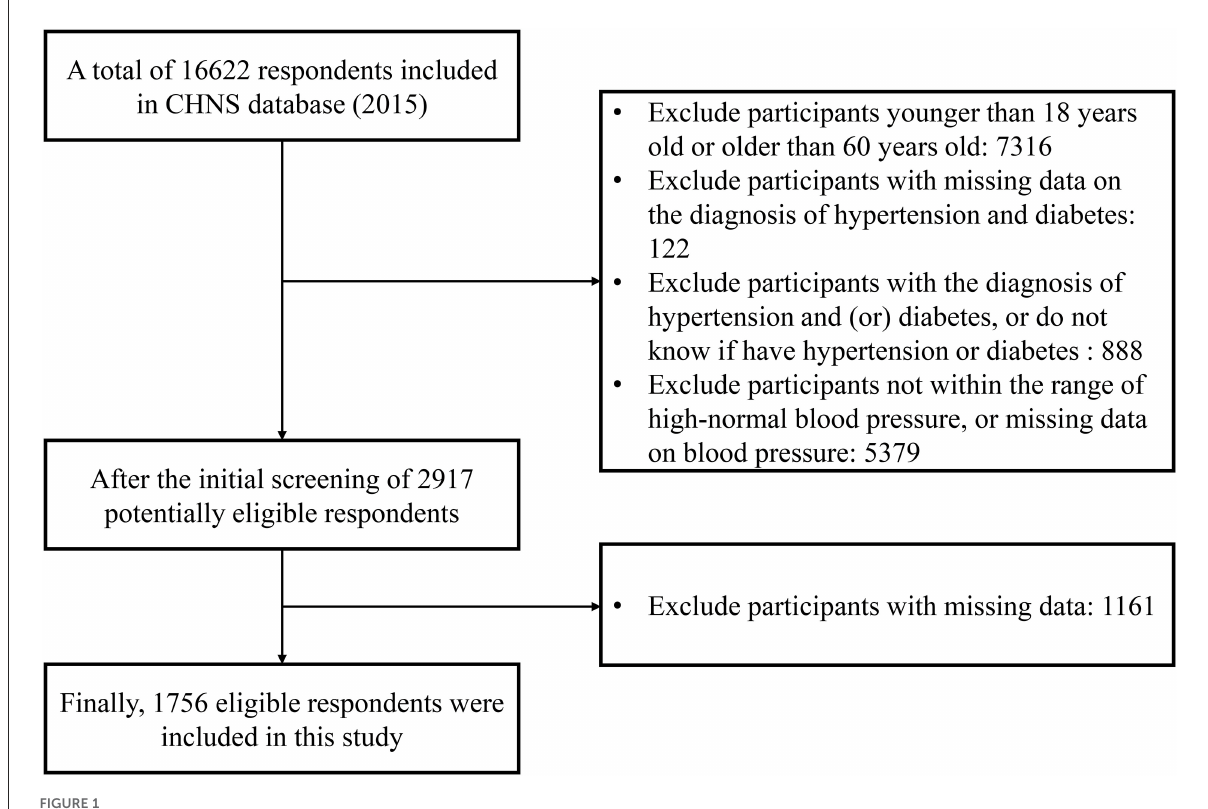
FIGURE1 Flowchart of subject recruitment and